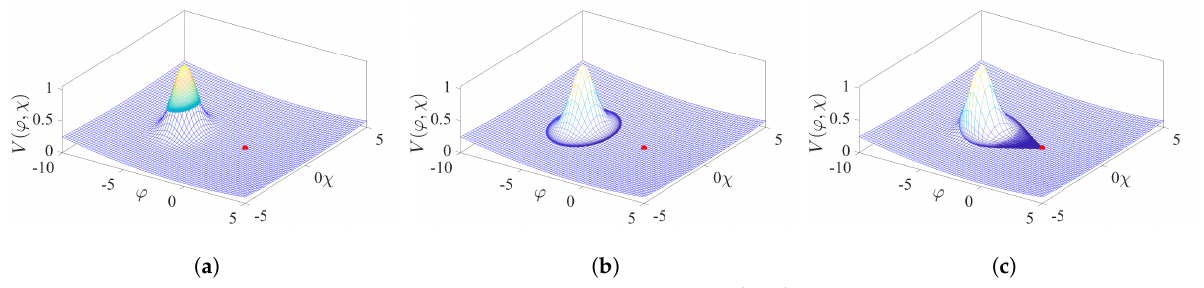
Figure 2. The potential (6) and the distribution (areas in dark blue) of the ( ϕ , χ ) -fields for ( a ) initial, ( b ) intermediate, and ( c ) final field configurations with the-final state, corresponding to the